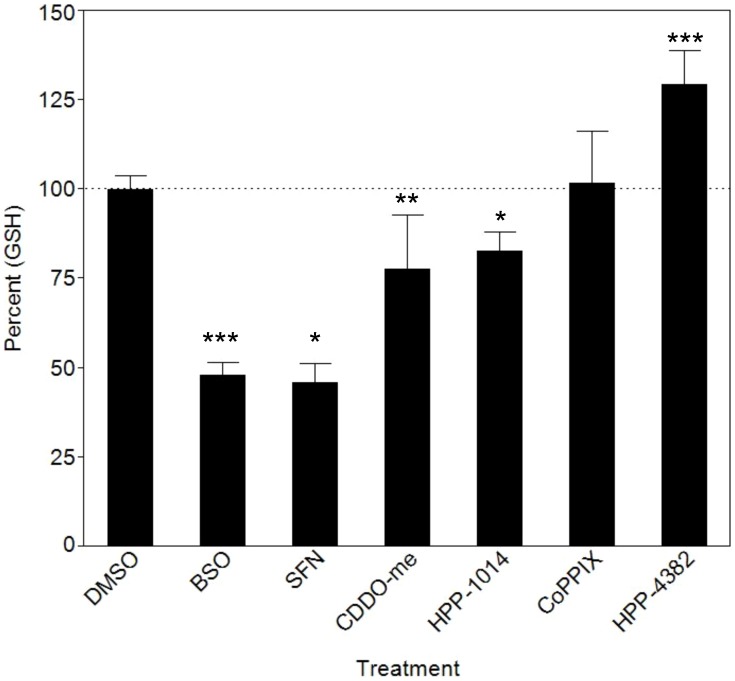
HPP-4382 increases cellular glutathione levels: NHLF cells grown in 96-well Optilux plates were treated with compounds for 4 hours (BSO, 200 µM; Sulphorafane, 10 µM; CDDO-Me, 0.1 µM; HPP-1014, 10 µM; CoPP, 10 µM; HPP-4382 3 µM) and glutathione levels were determined using the GSH/GSSG-Glo Assay Kit (Promega).Positive values show pairs of means that are significantly different. All samples in duplicate, error bars represent standard deviation compared to DMSO. *, p<0.05; **, p<0.01, ***; p<0.001.